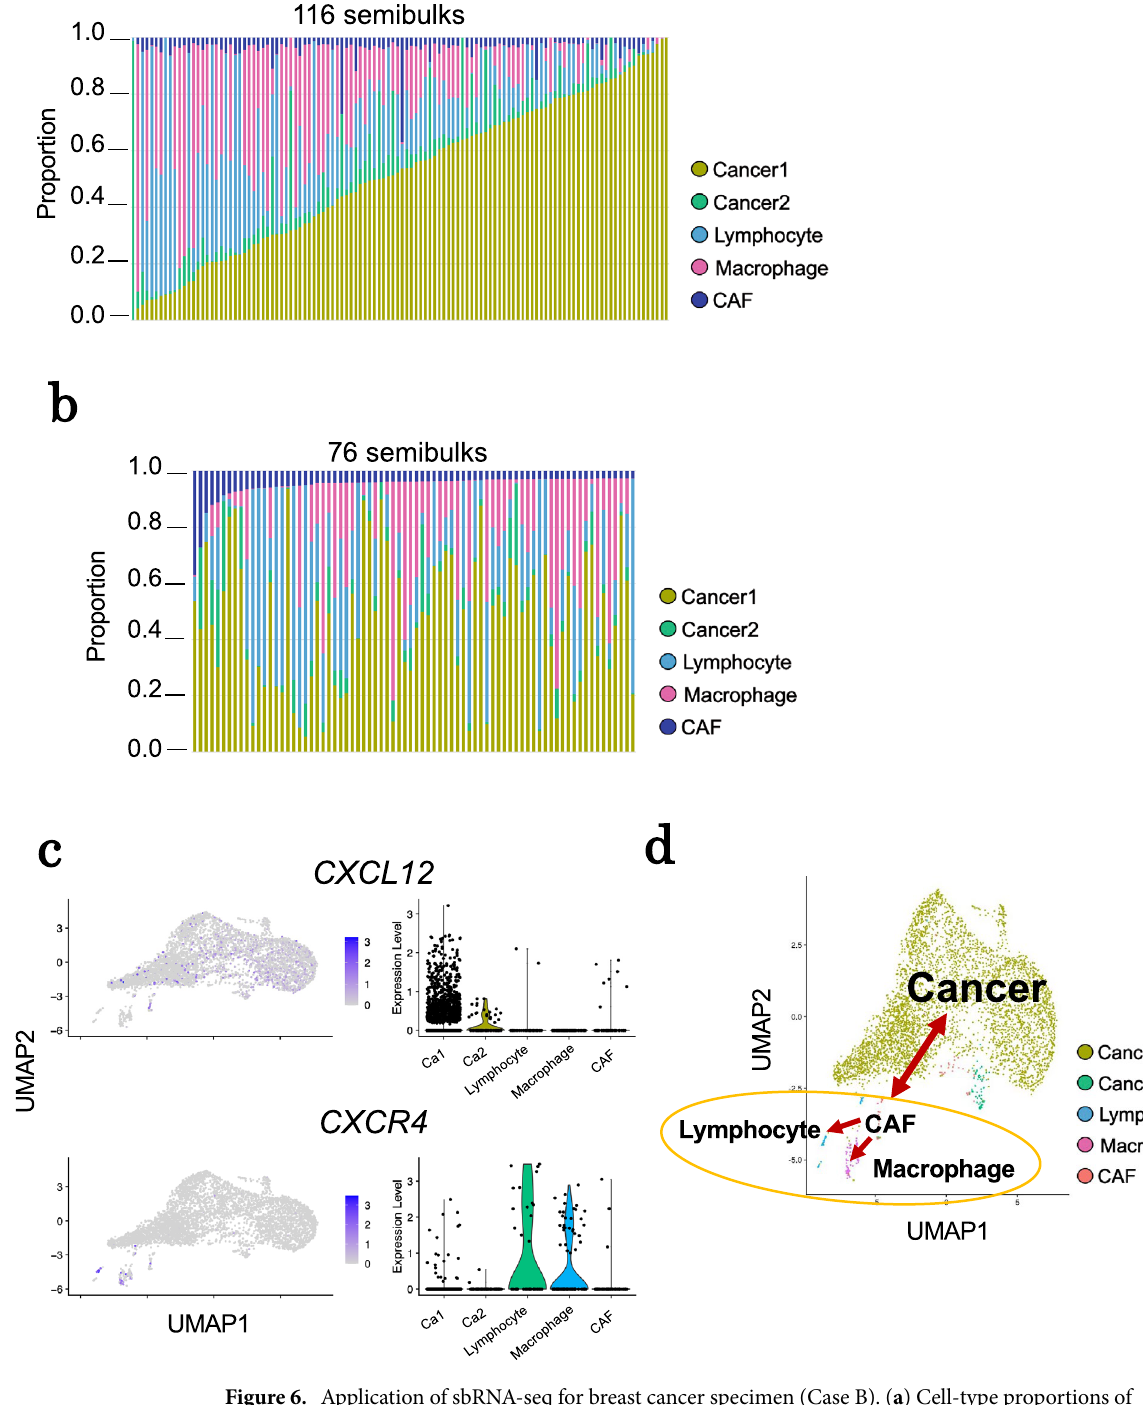
Figure 6. Application of sbRNA-seq for breast cancer specimen (Case B). ( a ) Cell-type proportions of 116 sbRNA-seq inferred by CIBERSORTx. The color key of cell types is shown in the margin. ( b ) Cell-type proportions of 76 semibulks containing > 3% CAF3 were shown. ( c ) Expression patterns of CXCL12 and CXCR4 in five cell-type clusters of scRNA-seq. ( d ) The potential association between each cell type shown on the UMAP plot of scRNA-seq data in Case